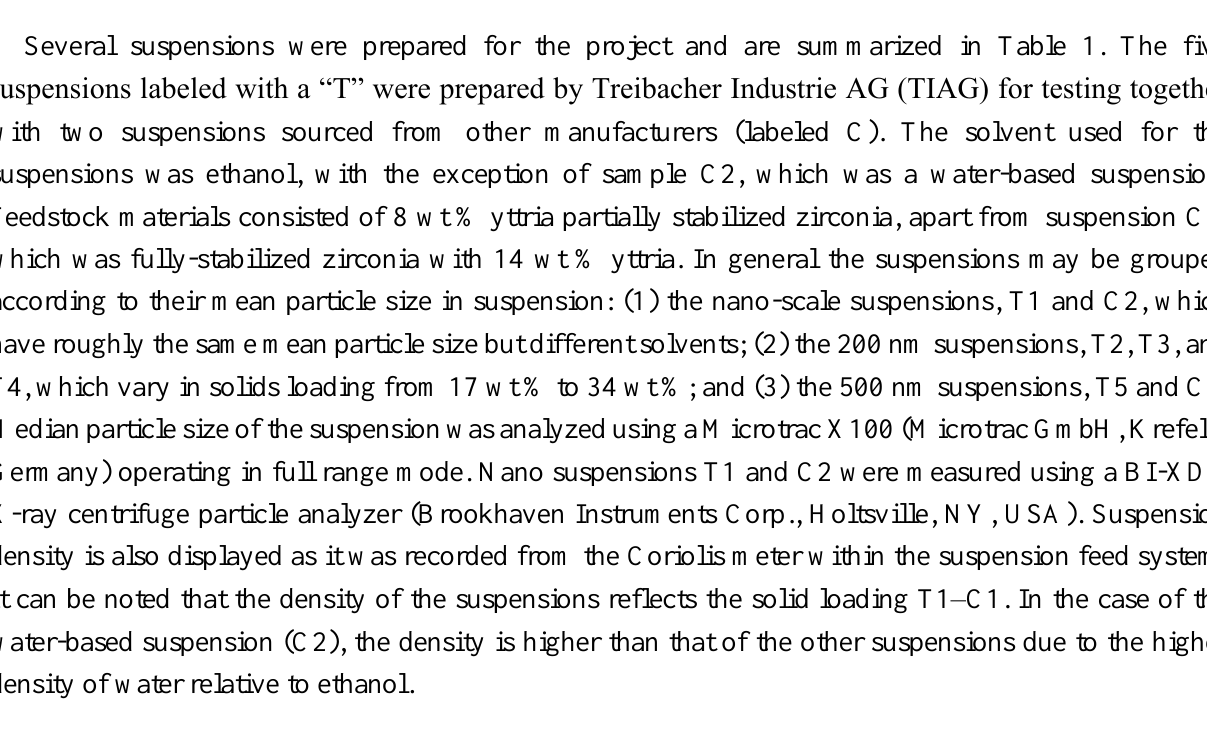
Table 1. Summary of experimental suspensions and coating deposition